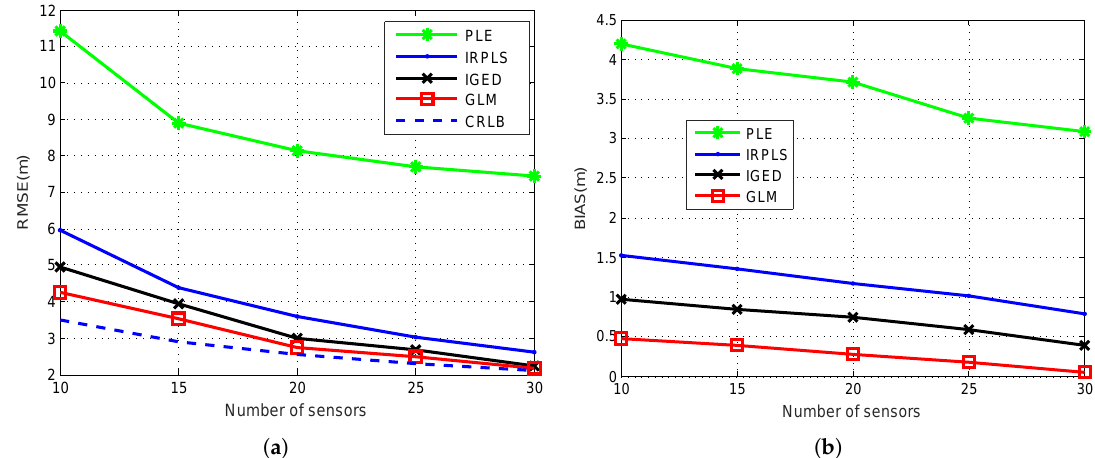
Figure 6. RMSE and bias performance comparison of PLE, IRPLS, IGED and GLM estimates with different number of sensors. ( a ) RMSE results. ( b ) Bias norm results.